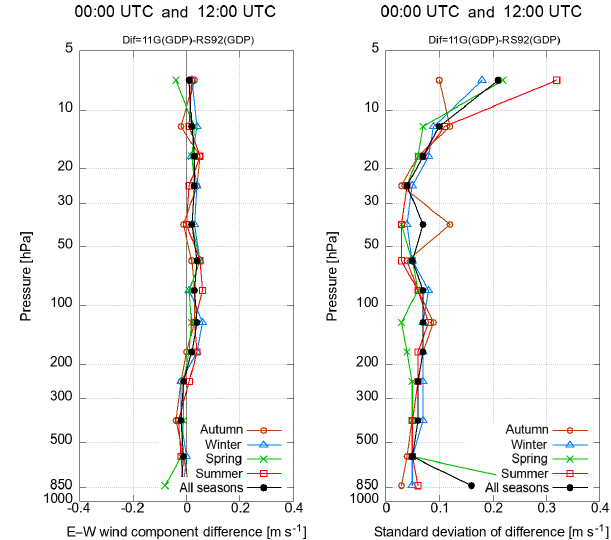
Figure 19. As per Fig. 17, but for U .